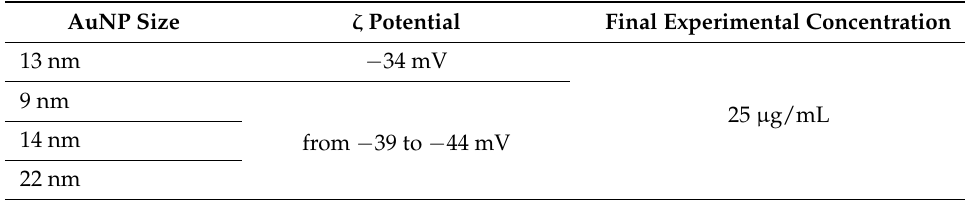
Table 1. Characteristics of AuNPs used in the study. AuNP Size ζ Potential Final Experimental Concentration 13 nm from − 39 to − 44 mV 14 nm